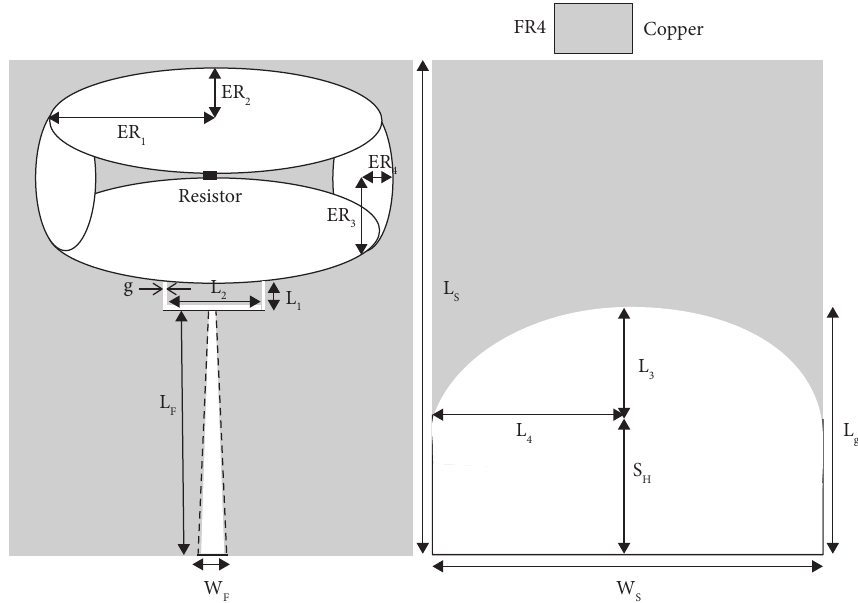
Figure 1: Geometrical construction of the planner SPA: (a) top radiator and (b) bottom view (ground plane).